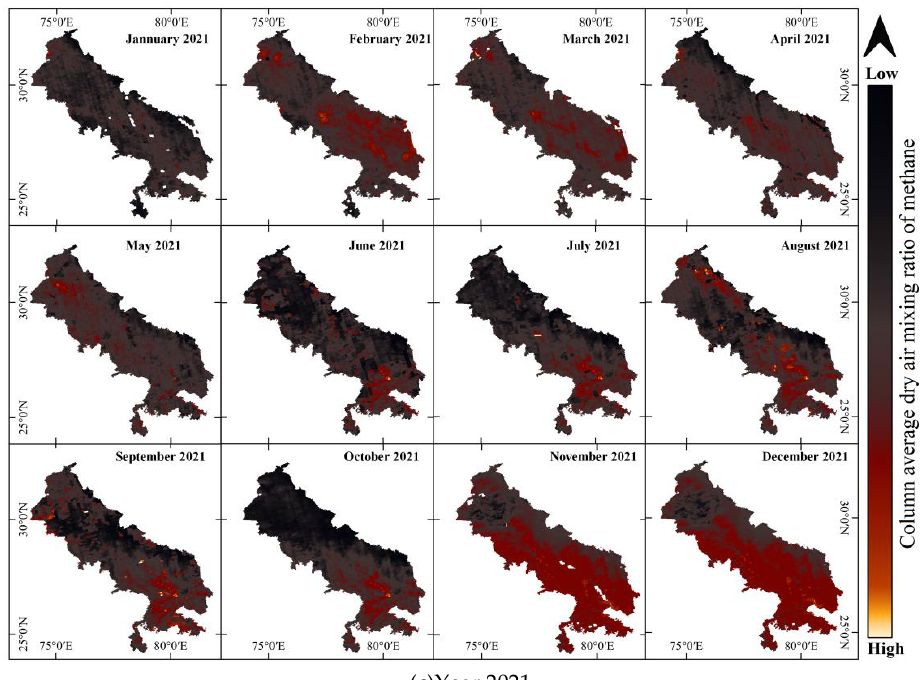
Figure 9. Atmospheric CH4 concentration over the study site (availability February 2019 to Decem- ber 2021).